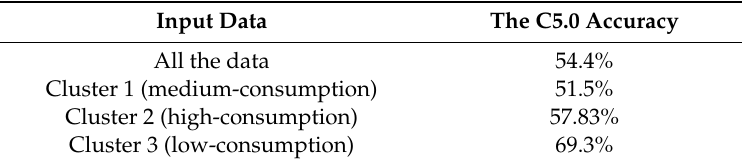
Table 6. Accuracy of the C5.0 Algorithm in the entire data and also in each